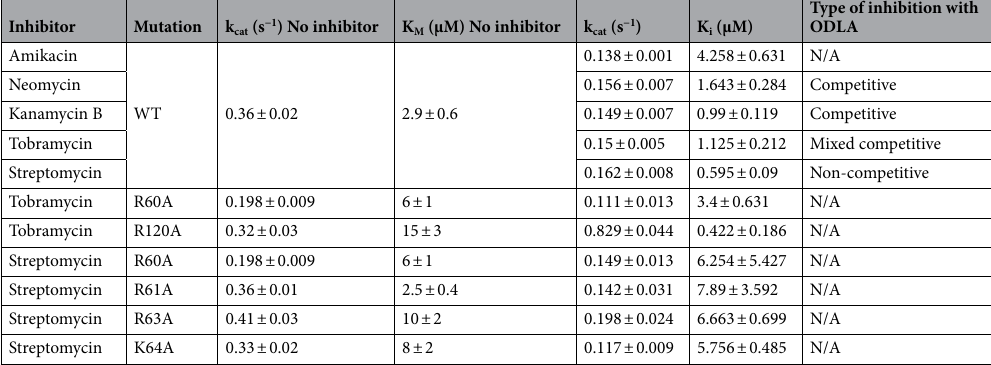
Table 1. Kinetic parameters of HepI in the presence/absence of aminoglycoside inhibitors and mutants of binding